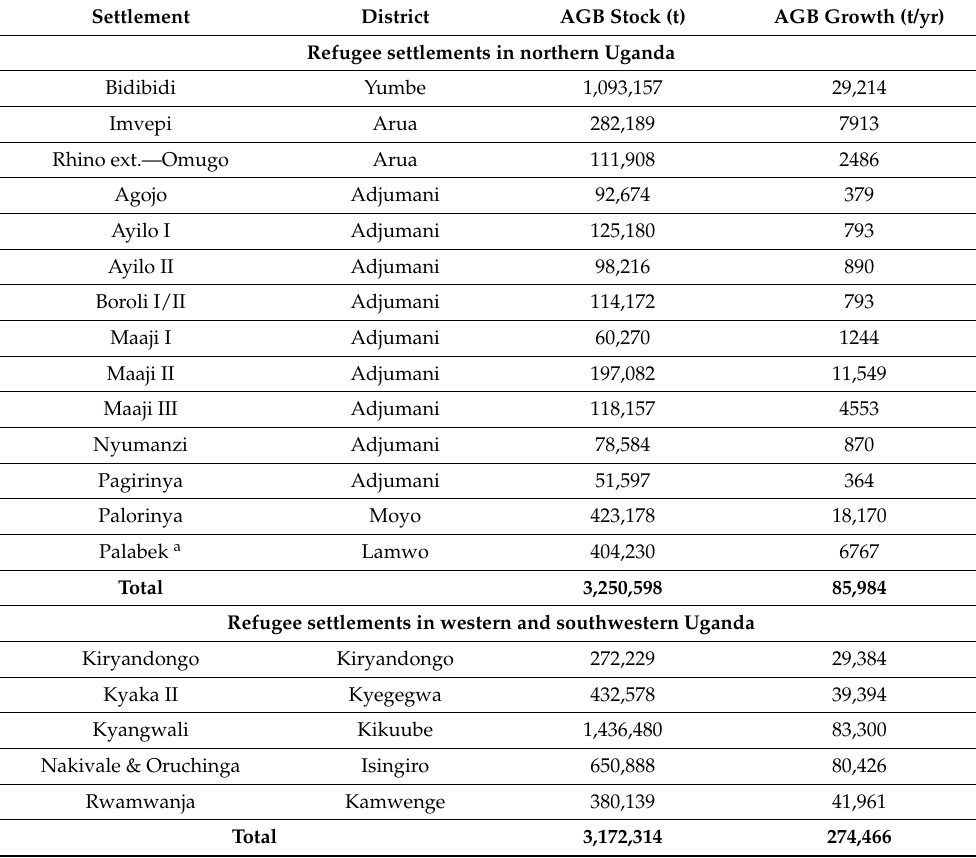
Table 8. Summary of AGB stock and AGB growth for each refugee settlement within 5